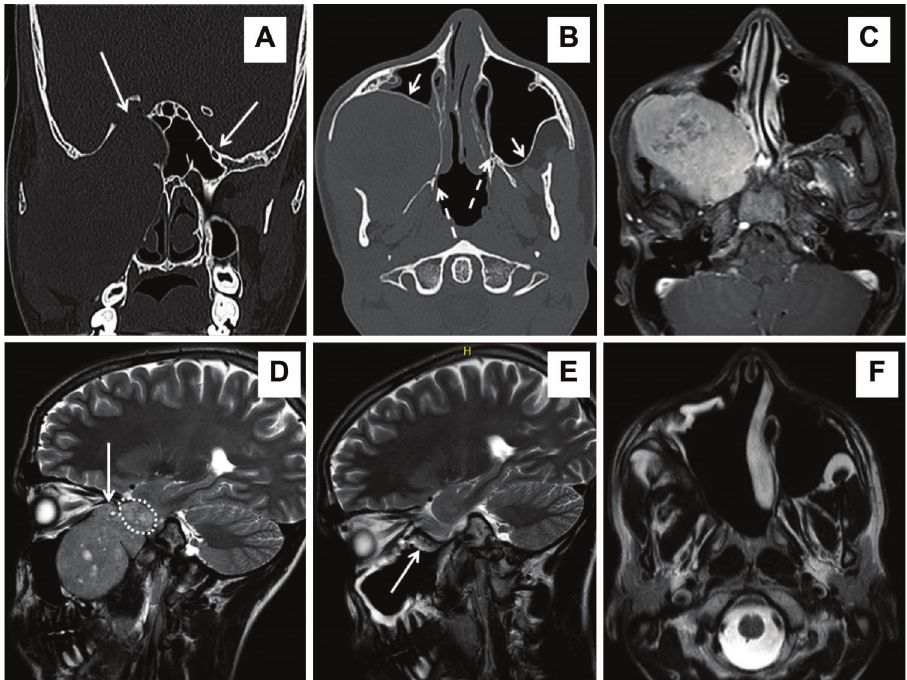
Figure 3 - Schwannoma of V2, case P11. Coronal (A) and axial CT (B) scans showing considerable deformation of the splanchno and neurocranium on the right side. A mass (74 x 65 x 61 mm) arising from V2 in the pterygopalatine fossa with bulky extension to the ITF, cheek, and middle cranial fossa via the foramen rotundum, which is extremely enlarged (long arrow) – see side difference. The schwannoma pushed the posterior wall of the maxillary sinus forward (short arrow) and the pterygoid process backward (dashed arrow) – also see side differences. (C) An axial T1-weighted MRI scan with gadolinium contrast showing the margin between the tumor and soft tissue. (D) A sagittal T2-weighted MRI scan showing that the tumor is pressing on the orbital apex via the infraorbital fissure (long arrow) with an intracranial portion (24 x 21 x 20 mm) in the middle cranial fossa (dotted line) . Postoperative T2-weighted MRI scans in the sagittal (E) and axial (F) planes demonstrate no evidence of disease 21 months after surgery. A nasoseptal flap (long arrow) was used to cover exposed dura mater of the middle cranial fossa, although no clear leakage of cerebrospinal fluid was observed intraoperatively. Considerable retraction of soft tissue into the postresection empty space of the cheek and ITF is visible on the axial MRI – compare (C) and